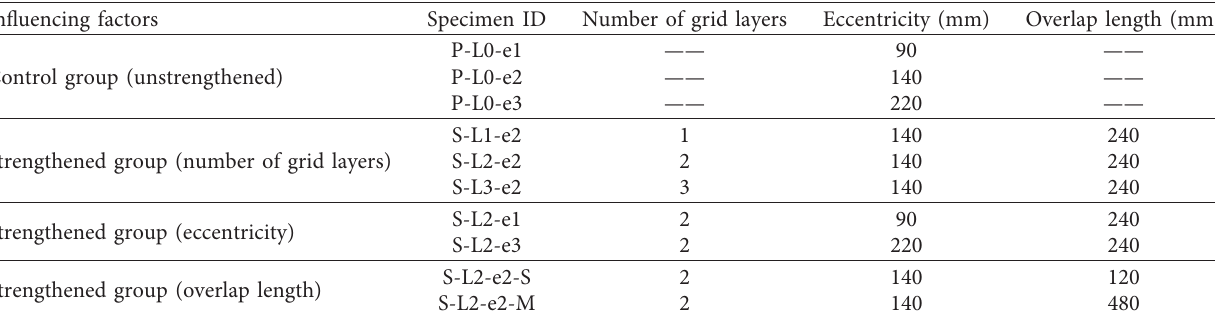
Table 3: Summary of tested specimens.